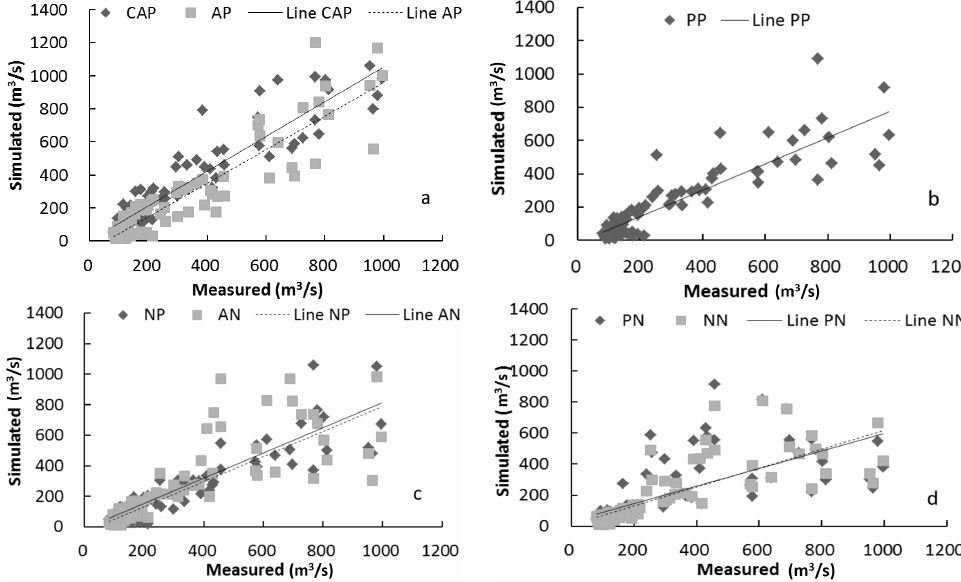
Figure 7. Comparison of simulated flows from seven models. ( a ) Scatter plot and fitting curves of measured and simulated flows by model CAP and AP; ( b ) Scatter plot and fitting curve of measured and simulated flows by model pp; ( c ) Scatter plot and fitting curves of measured and simulated flows by model NP and AN; ( d ) Scatter plot and fitting curves of measured and simulated flows by model PNand NN.